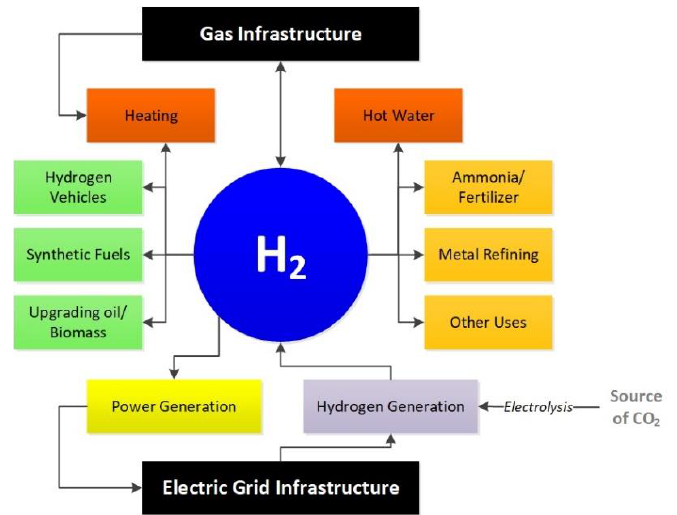
Figure 5. The hydrogen utilization